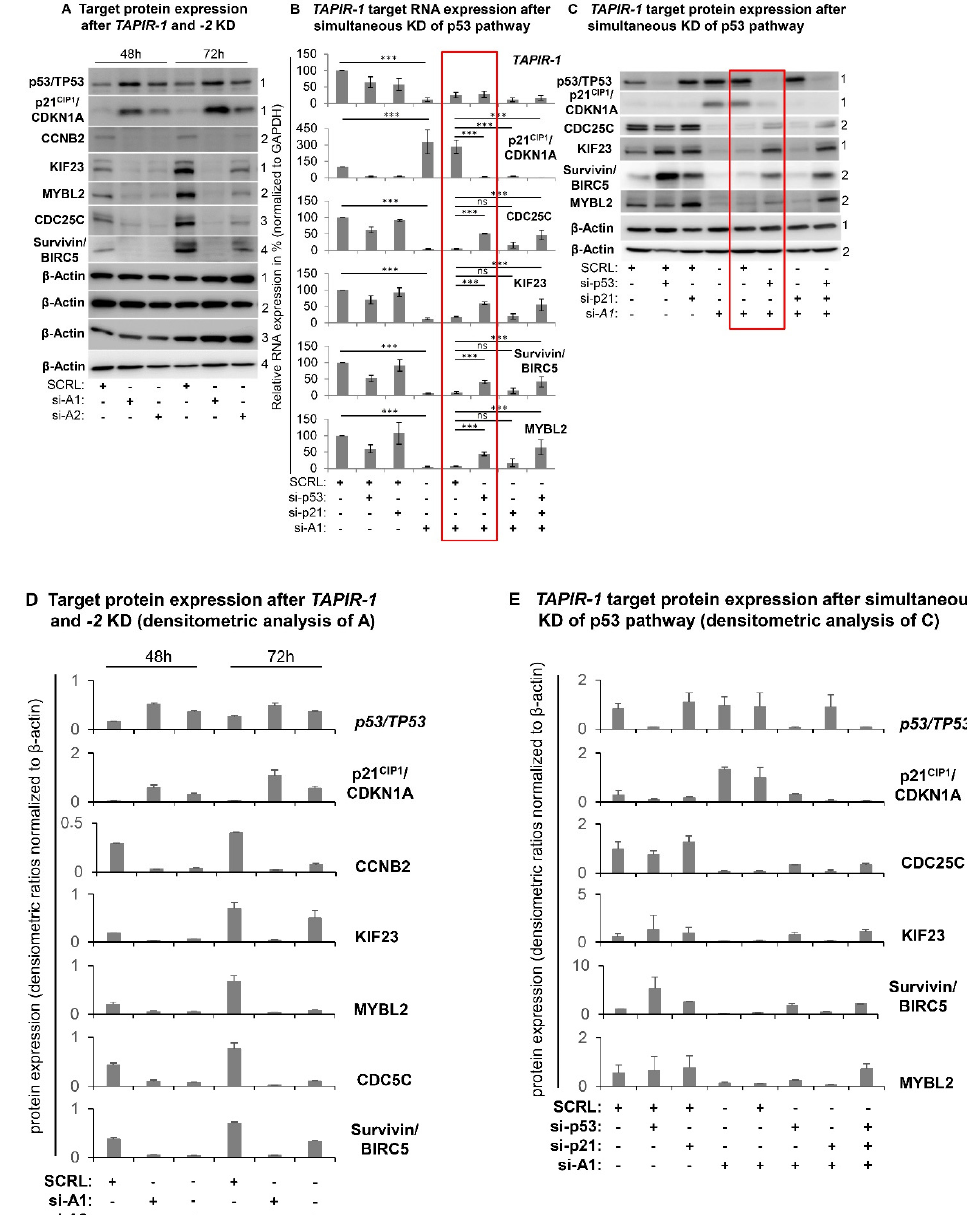
Figure 5. TAPIR-1 knockdown induces the p53-DREAM pathway. LNCaP cells were transfected with siRNAs against TAPIR-1 , TAPIR-2 , p53 / TP53 , p21 CIP1 / CDKN1A (p21), and a scrambled control (SCRL) and cultured for 48 h and 72 h. ( A ) Expression pattern of cell cycle regulating target proteins after TAPIR-1 knockdown. Post siRNA transfection protein lysates were prepared at 48 h and 72 h. SDS-PAGE and western blot were performed to detect upregulation of p53 and p21 CIP1 and downregulation of CDC25C , cyclin B2 / CCNB2 , KIF23 , MYBL2 , and Survivin / BIRC-5 protein targets. β -actin was used as loading control. One of two independent experiments with equal results is shown. ( B ) Results of qPCR-based expression analysis of di ff erent genes 48 h post transfection with siRNAs directed against TAPIR-1 (si-A1), p53 / TP53 , and p21 CIP1 / CDKN1A are shown. The ∆ Ct values were determined by subtracting the Ct value of the housekeeper Ct value (GAPDH). Each qPCR reaction was